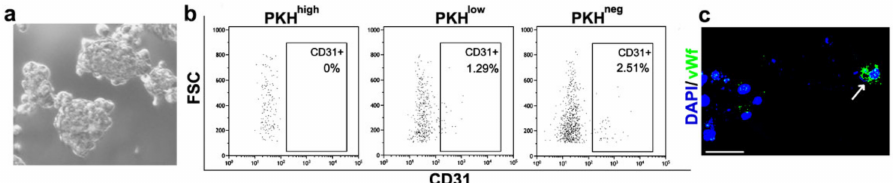
Figure 3. Characterization of secondary NS generated from FACS-sorted CD31- RSC. ( a ) Contrast-phase image of secondary NS generated from CD31- RSC FACS sorted from primary NS; ( b ) FACS analysis of CD31 expression in PKH high , PKH low , PKH neg cell subpopulations of secondary NS cells gated on PKH26 fluorescence; ( c ) IF analysis of cytospinned cells obtained from secondary NS dissociation. Antibody against vWf was used. Blue—DAPI. Original magnification 400 × . Scale bar, 50 µ m. Arrow: vWf +